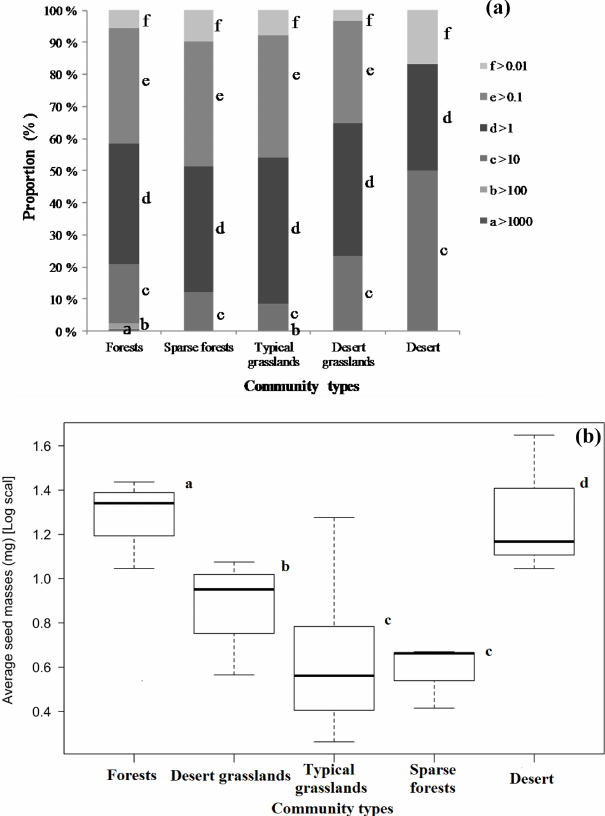
Figure 1. Seed mass spectra vary among five community types in Inner Mongolia (a) , and proportions of larger seeds (a) and average seed mass (b) decline from forests to desert grasslands but increase in deserts (average seed masses bearing the same letters are insignif- icantly different at p > 0 .